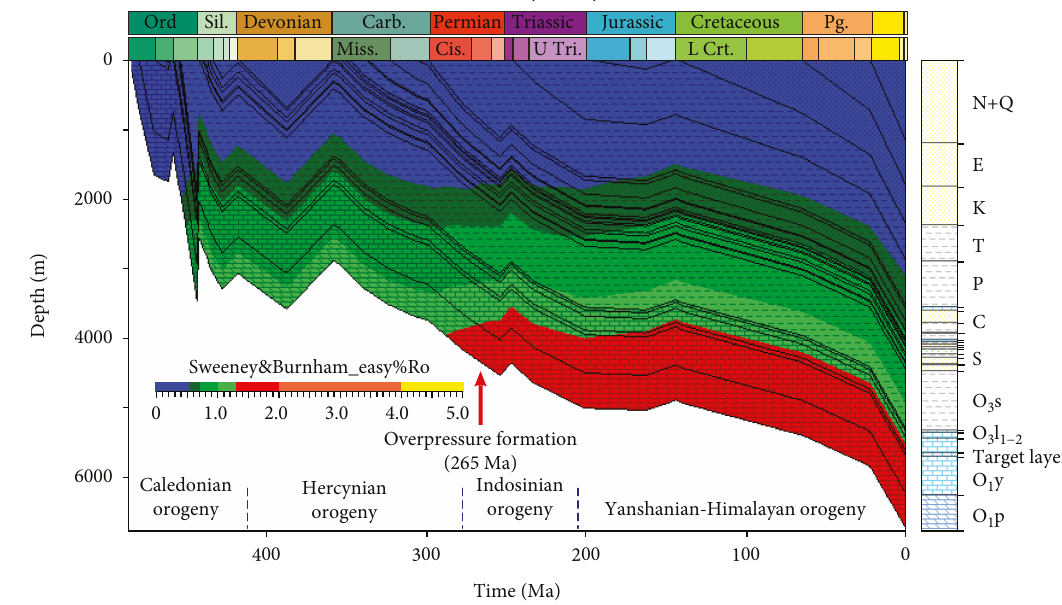
Figure 6: The burial history overlaying the thermal maturity history of Well ZG7-5.